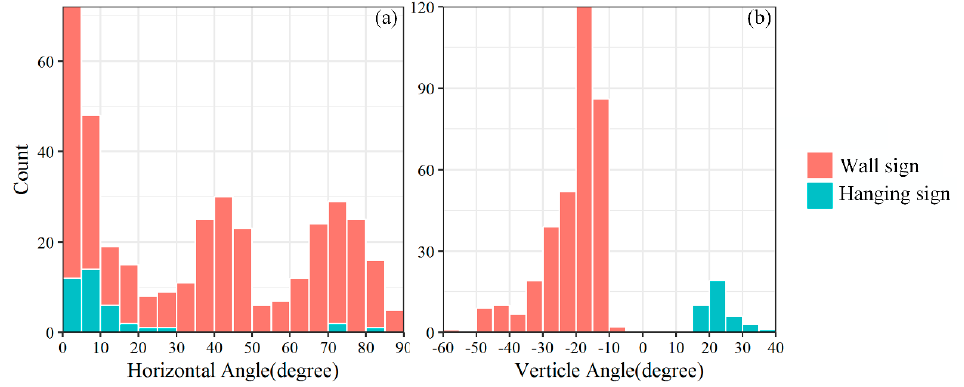
Figure 11. Visual angles of evacuation signs: horizontal angles ( a ) and verticle angles ( b ).